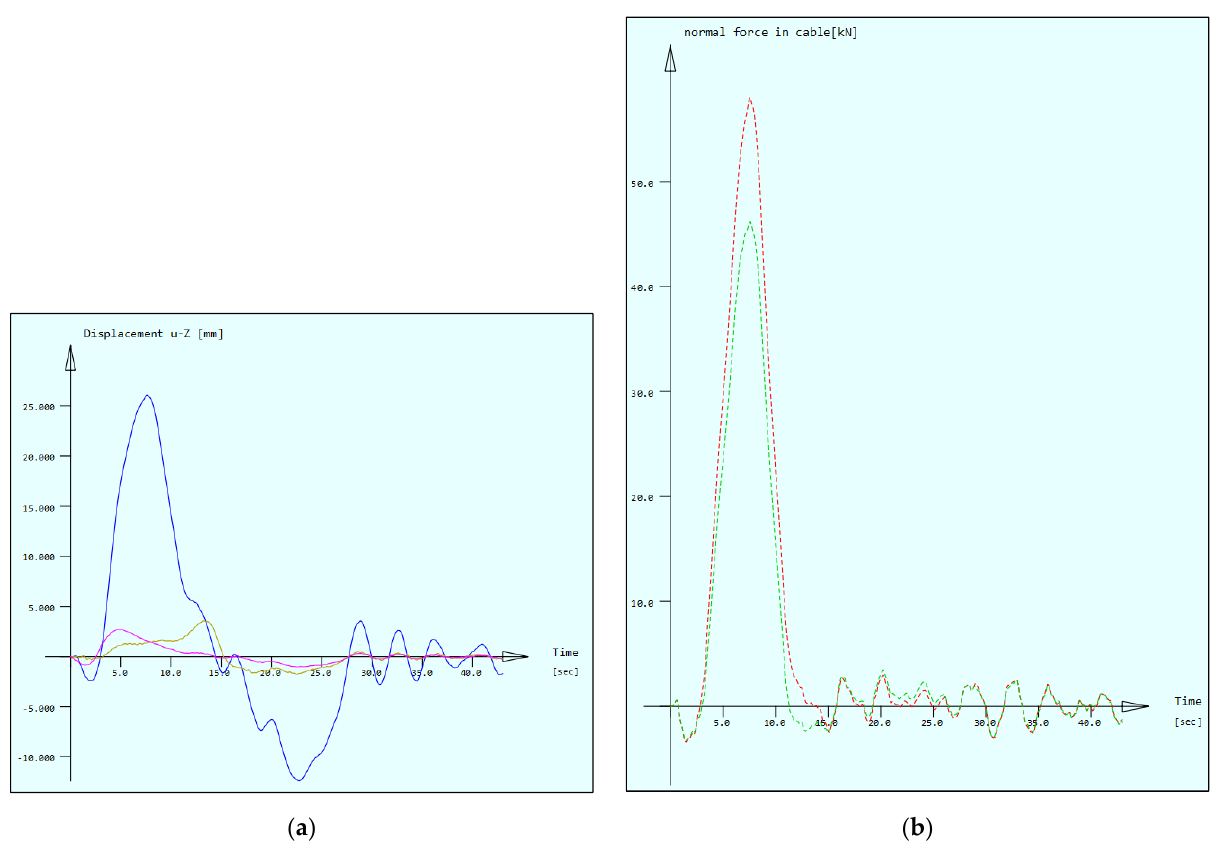
Figure 14. ( a ) Node displacements for 3 measuring points on one span, magenta line: deck point under the longest cables W40, dark blue line: deck point under the medium–long cables W32, brown line: deck point under the shortest cables W21; ( b ) tension force in the whole cables W12, red line: outer deck cable, green line: inner deck cable.